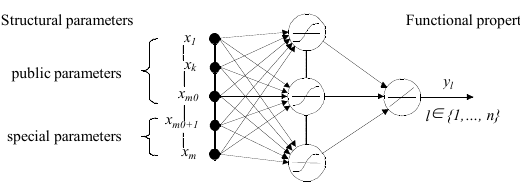
Fig. 5a. General model including only public structural parameters